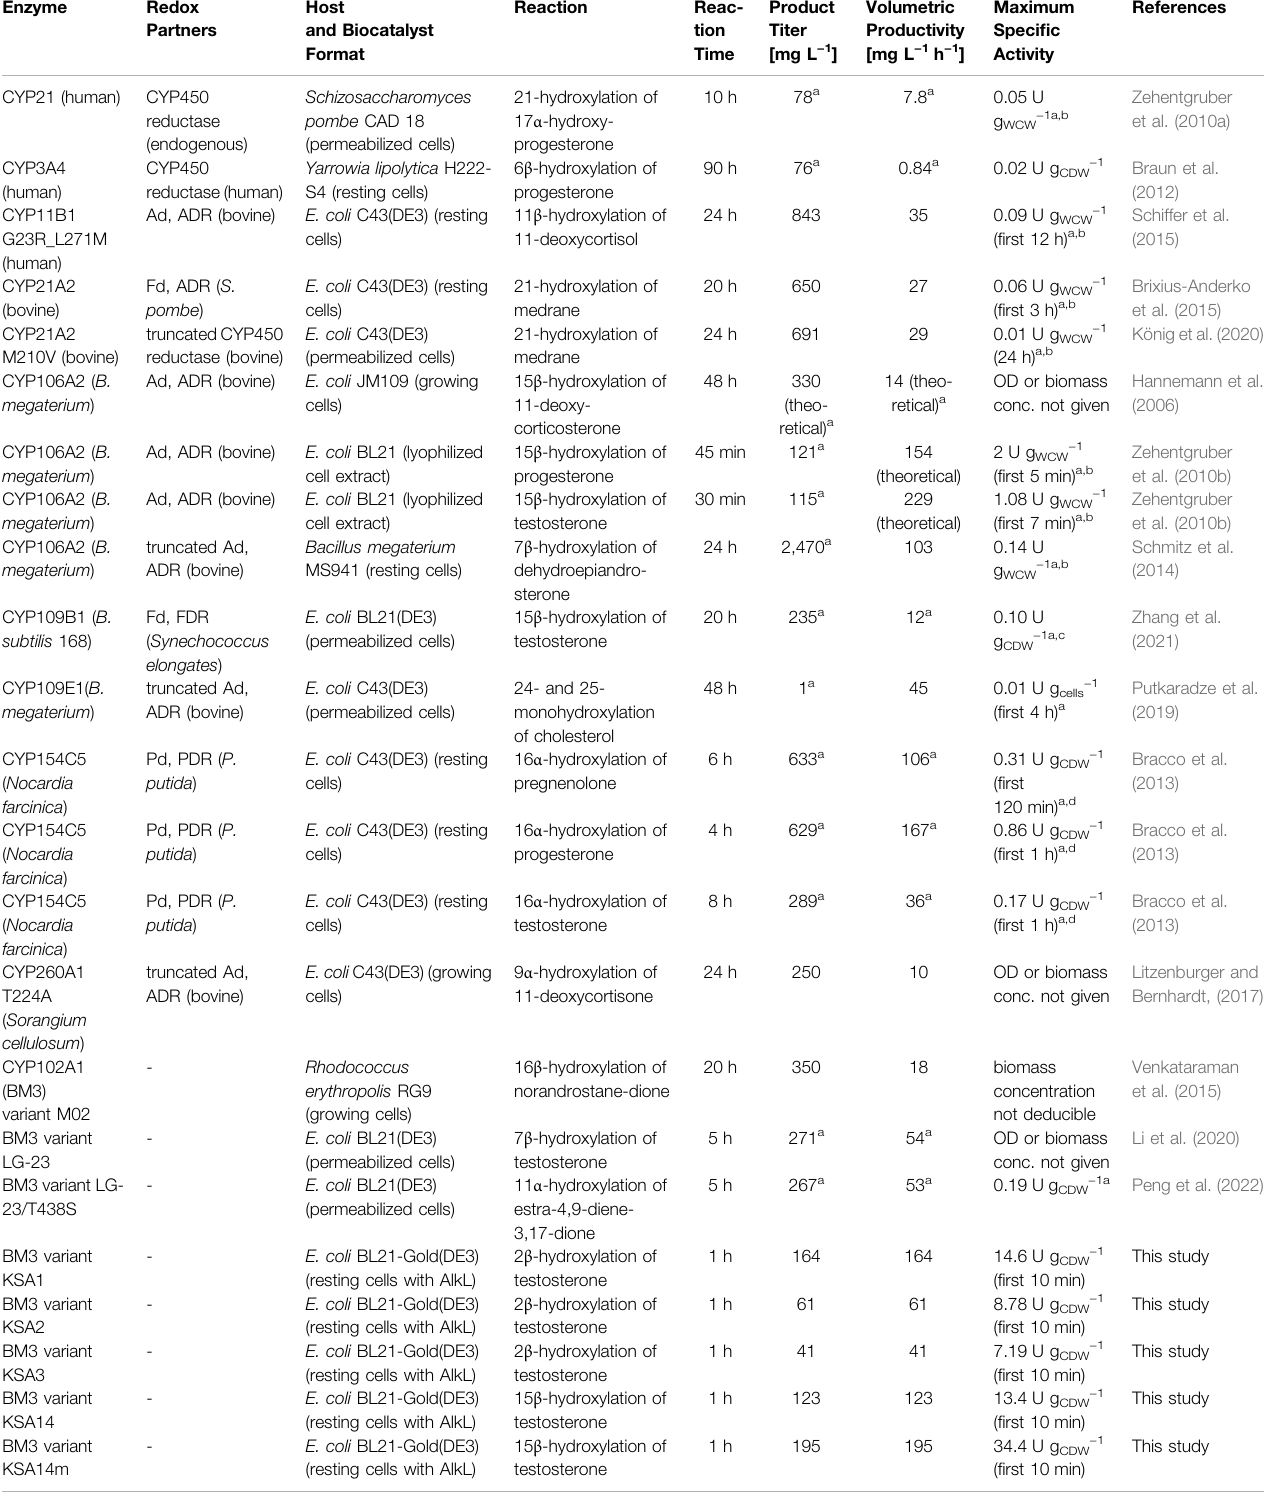
TABLE 2 | CYP450-catalyzed steroid hydroxylation ef fi ciencies.